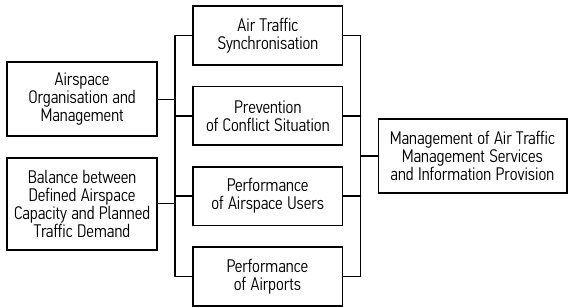
Fig. 2. Elements of the air traffic management